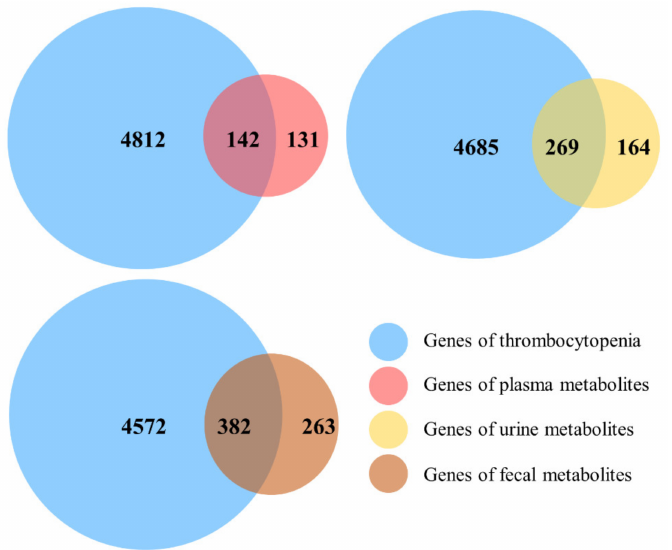
Figure 3. The Venn diagram of targets between thrombocytopenia and metabolites. The targets of thrombocytopenia were marked in blue, and the targets of metabolites from plasma, urine, and feces were marked in red, yellow, and brown,